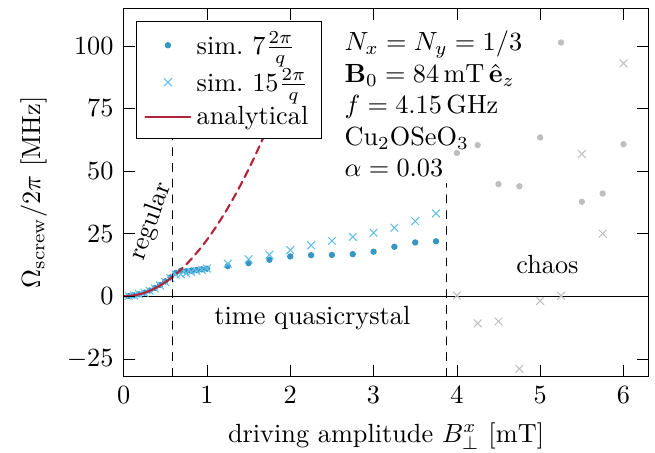
Figure 8: Screwing frequency as a function of the amplitude of the oscillating mag- netic field, B x (parameters as in Fig. 3, with driving frequency f = 4.15 GHz) for ⊥ two different sizes of the simulated system (7 and 15 times the pitch of the helix). For small fields Ω , the Archimedean screw solution is found, following the analytic screw prediction which high accuracy. Similarly, an instability resulting in the formation of a time quasicrystal occurs as predicted. The onset of the instability is slightly delayed π does for the smaller system, as the predicted wavelength of the instability λ ≈ 7.7 2 q (cid:166) 3.8 mT we obtain chaotic not match the boundary conditions in this case. For B x ⊥ solutions discussed in more detail in Appendix